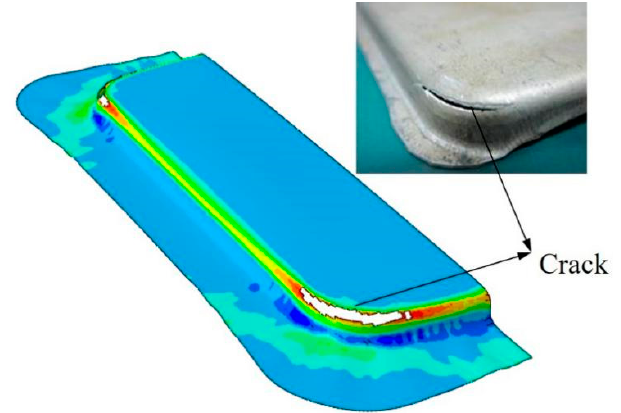
Figure 3. Comparison between results from numerical simulations and hot-stamping experiments.